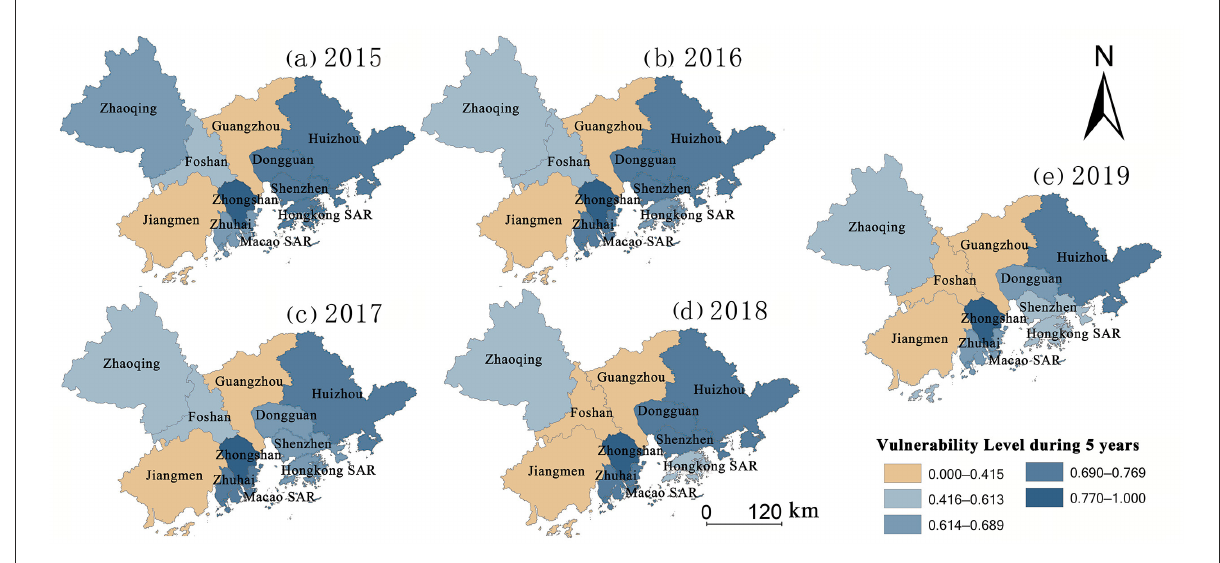
FIGURE7 (a–e) Temporal and spatial evolution map of vulnerability level in GBA from 2015 to